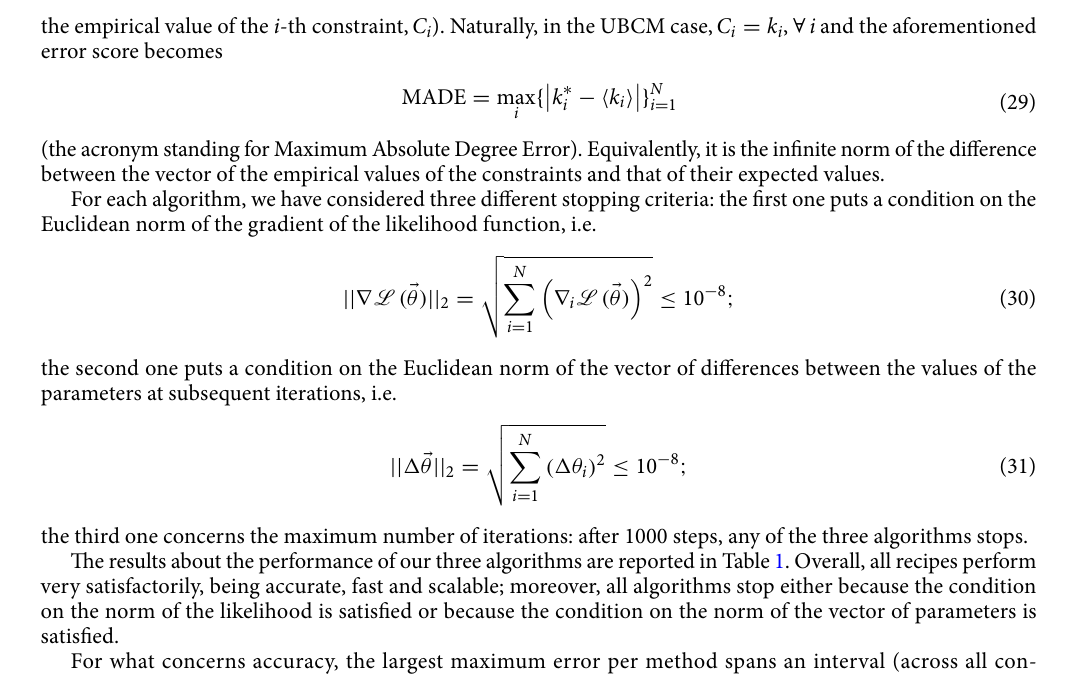
k i , i and the aforementioned = ∀